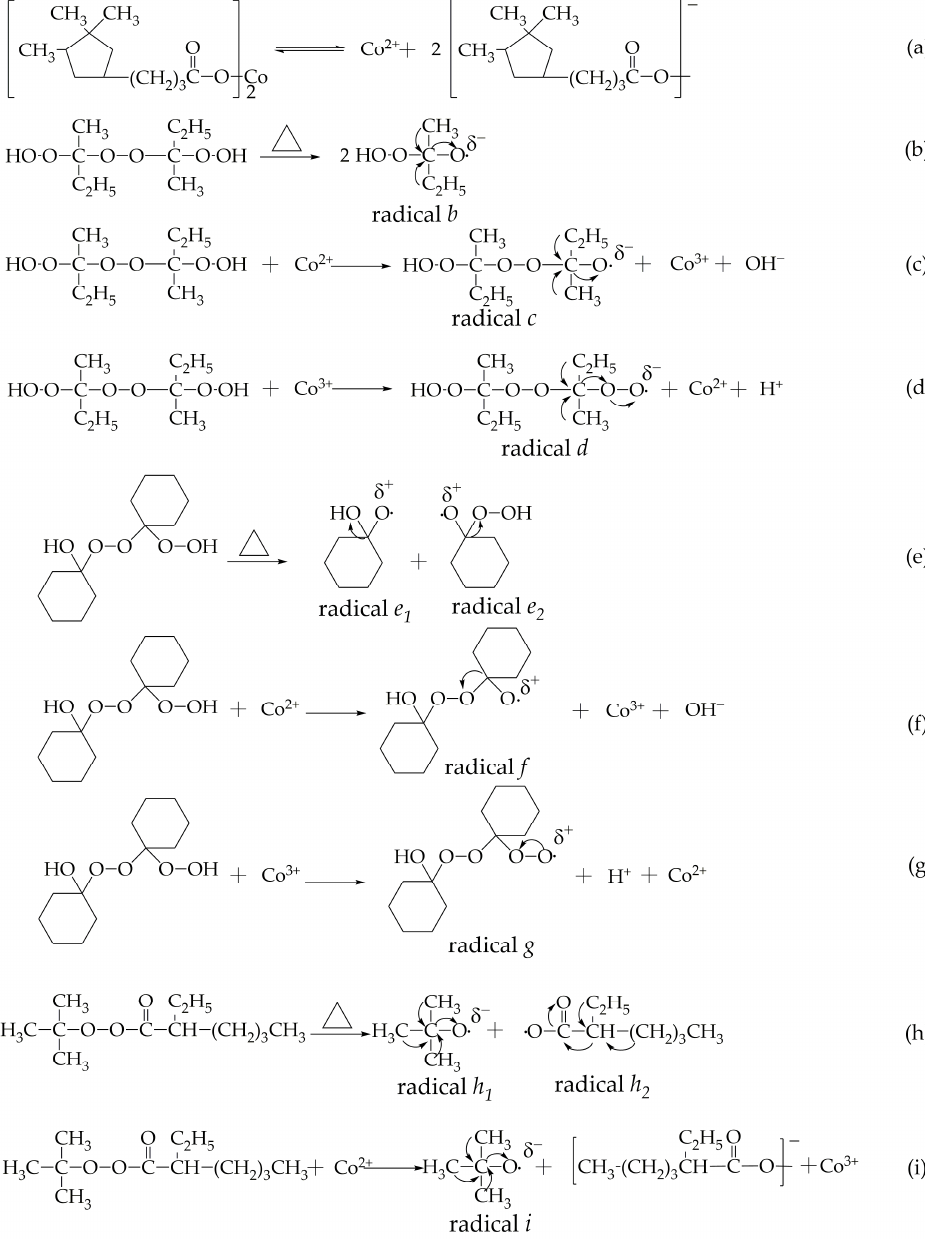
Figure 7. Decomposition equations of accelerator and initiators, ( a ) decomposition of accelerator cobalt naphthenate, ( b ) spontaneous decomposition of MEKP- Ⅱ , ( c , d ) decomposition of MEKP- Ⅱ with the promotion of cobalt ions, ( e ) spontaneous decomposition of CYHP, ( f , g ) decomposition of CYHP with the promotion of cobalt ions, ( h ) spontaneous decomposition of MEKP- Ⅱ , ( i ) decomposition of TBPO with the promotion of cobalt ions.